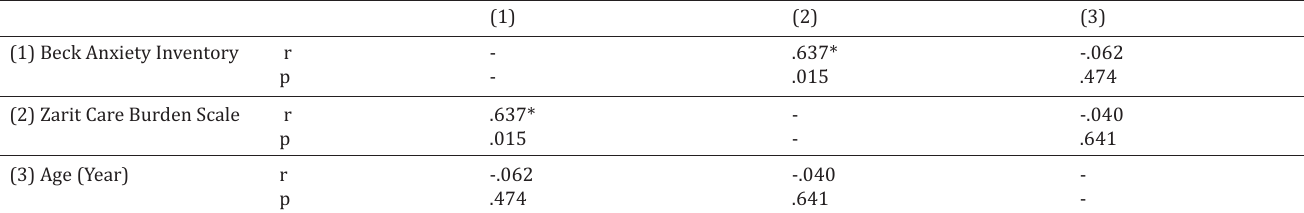
The Relationship Between Beck Anxiety Inventory and Zarit Care Burden Scale Total Score Median and Age